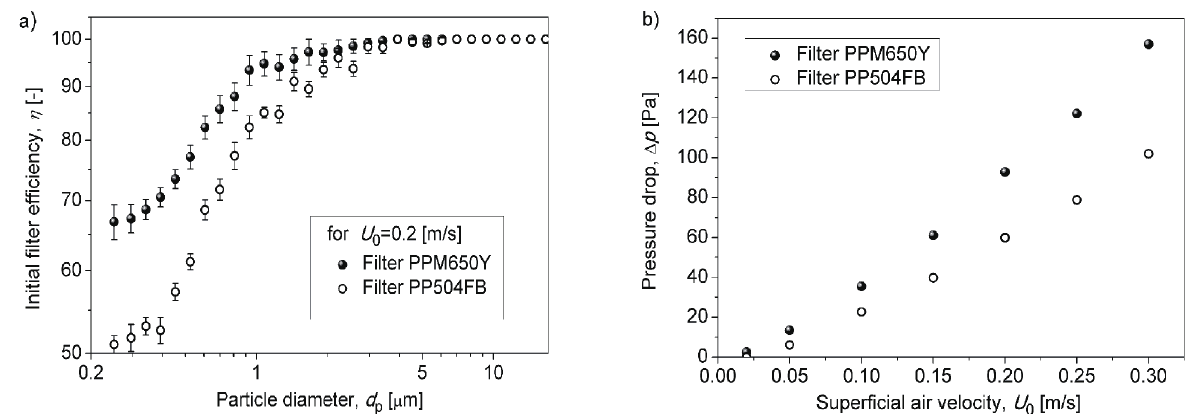
Fig. 6 Initial performance of filters made of various materials : a) filter efficiency and b) pressure